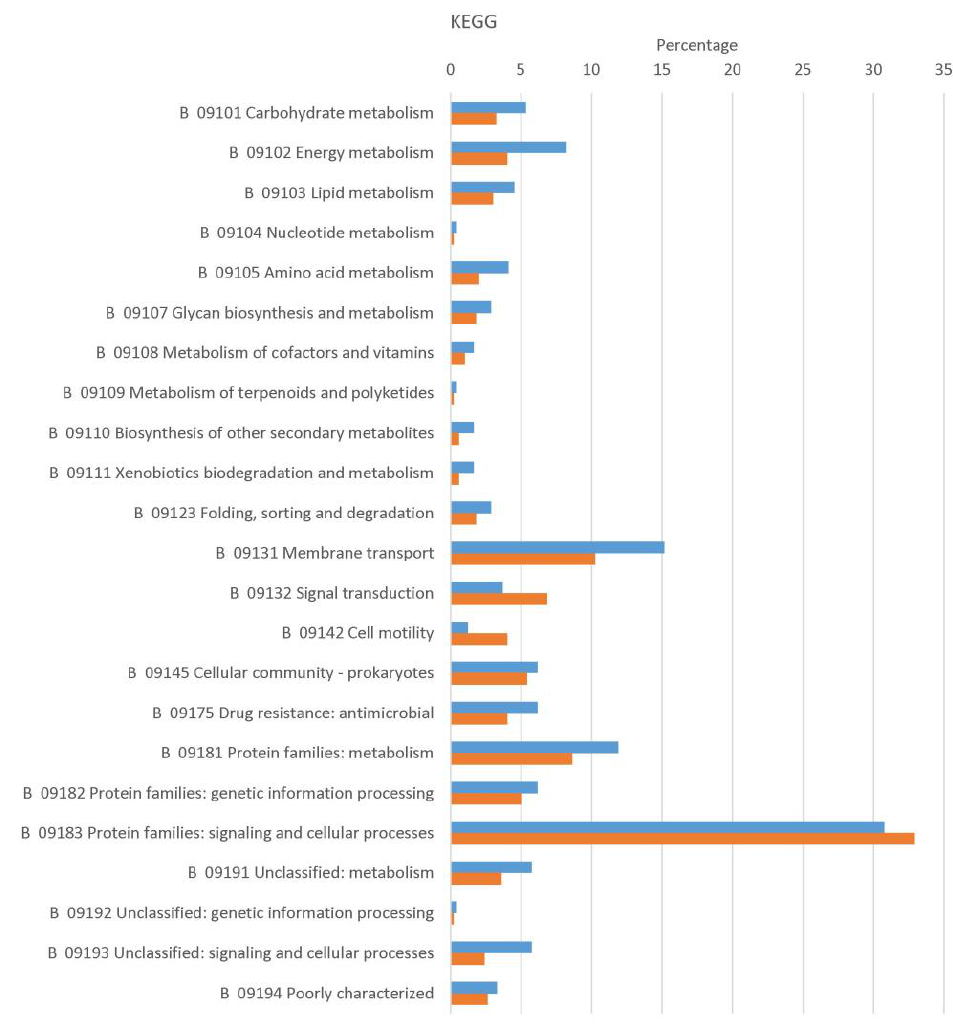
Figure 2. Functional categories of membrane proteins identified in spore inner membrane and cell membrane of B. cereus . Involvement in various KEGG pathways. The percentage of the total number of proteins (spores: 244, cells: 498) assigned to KEGG terms are shown for cells (orange) and spores (blue). Table 1. Germination associated proteins identified in this study.